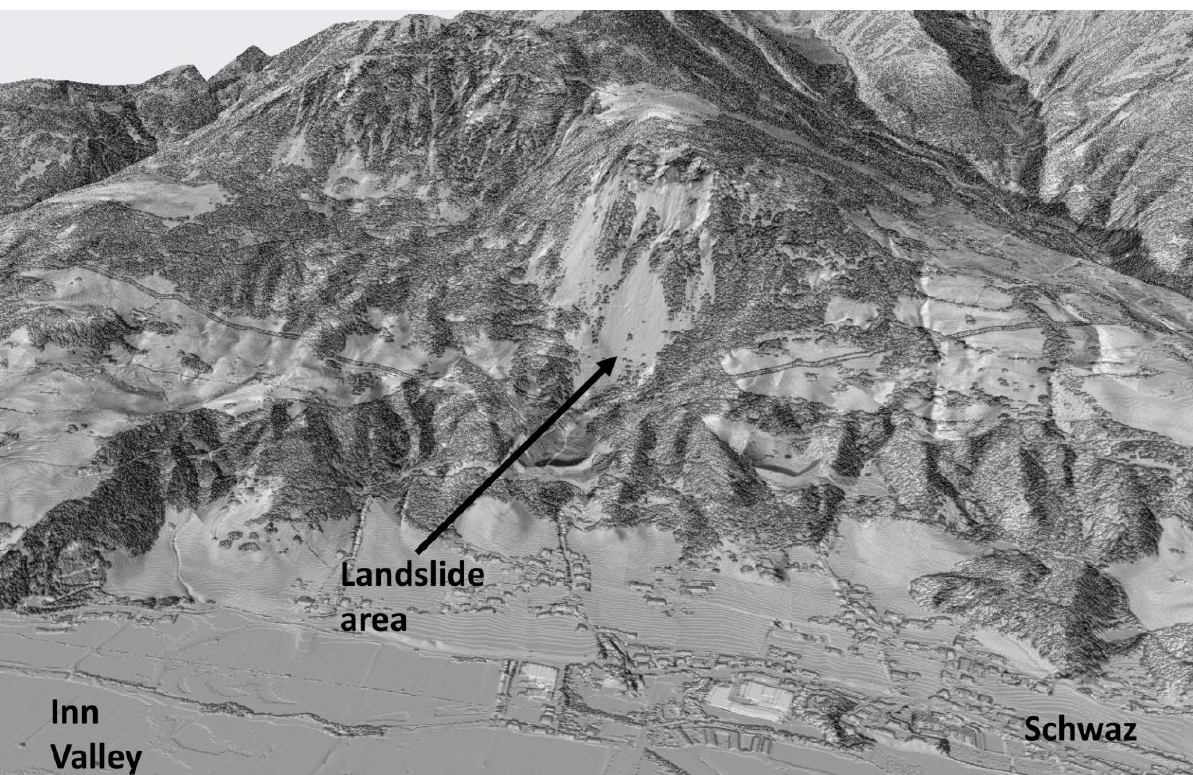
Figure 1. Mining landscape of Schwaz in the Tyrol indicating the landslide of the Eiblschrofen in the high resolution surface model of the province of Tyrol (source: Land Tirol